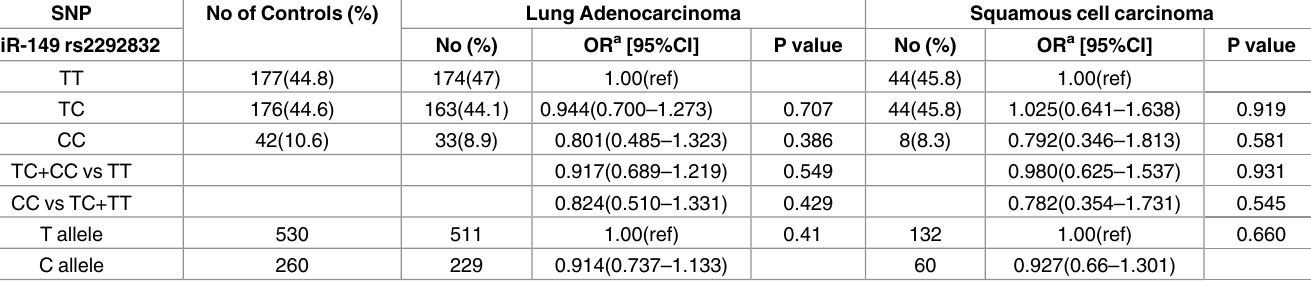
Table 3. Distributions of rs2292832genotypes and alleles in two groups and their associations with risk of lung adenocarcinoma and squamous cell carcinoma. SNP